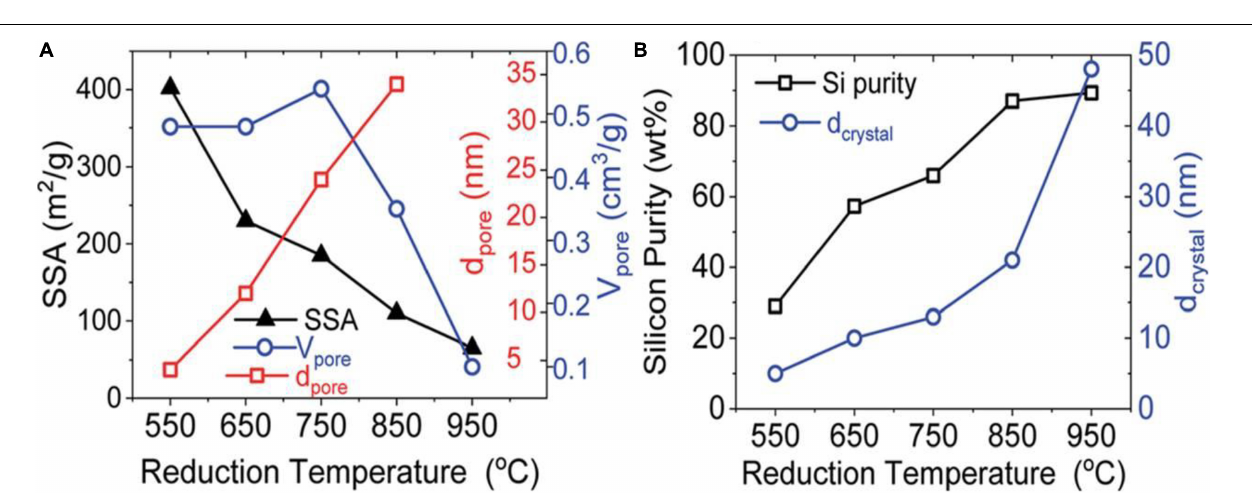
FIGURE 5 | (A) XRD patterns of products from reactions between SiO 2 and Mg at different ratios. Reprinted from Ref. (Barati et al., 2011), with the permission of Elsevier. (B) Calculated influences of Mg powder usage and temperature on product composition by simulation. Reprinted from Ref. (Zakaryan et al., 2017), with the permission of Springer